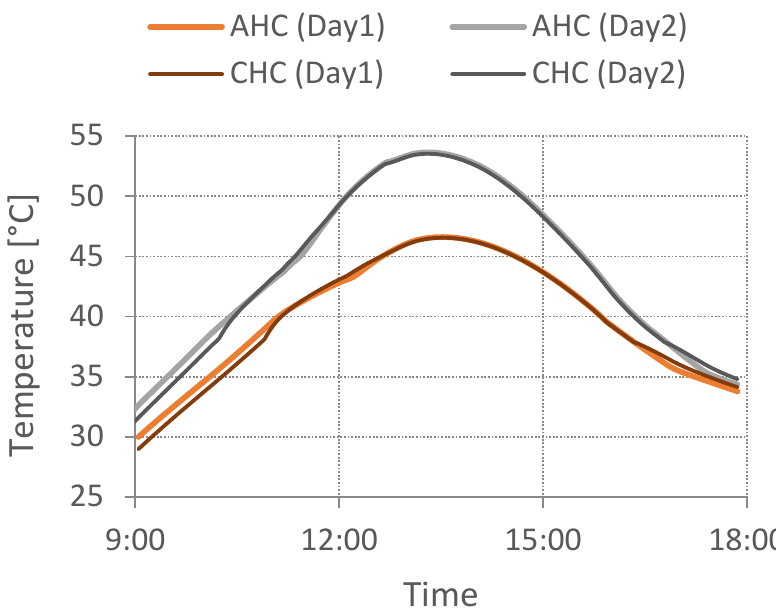
Figure 7. PV panel backside temperature values obtained using two methods of PCM definition.